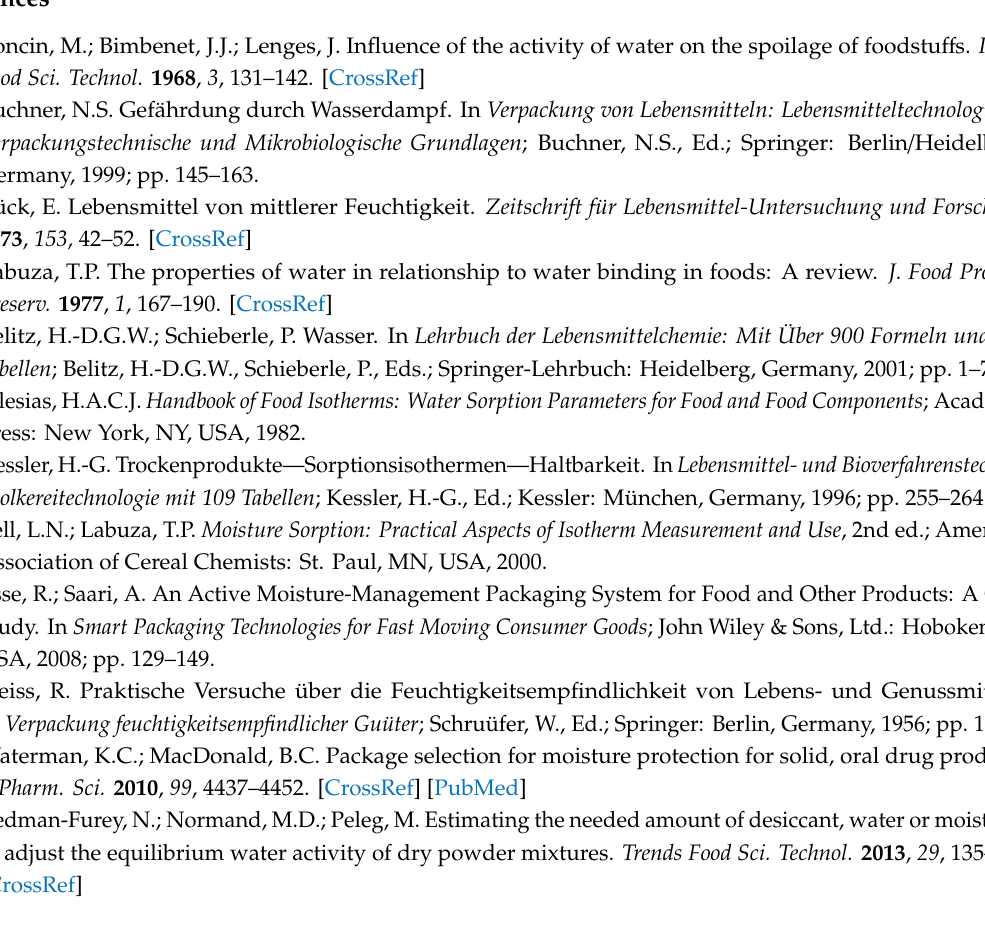
Figure S1: Elongation by water vapour absorption. Elongation of PE-LD samples with di ff erent amounts of silica gel -powder after 260 days; samples stored at 91 % RH and 23 ◦ C; Figure S2: Electron microscopic pictures of the sample films in di ff erent magnifications. ( a ) Electron microscopic pictures of film with 0.2 g silica gel / g film; ( b ) Electron microscopic pictures of film with 0.6 g silica gel / g film.; Figure S3: Determination of (e ff ective) di ff usion coe ffi cients by lag-time measurements; (a) Determination of lag-times of PE-LD films; 23 ◦ C; (b) Determination of lag-times of PE-LD films with dispersed silica gel; 23 ◦